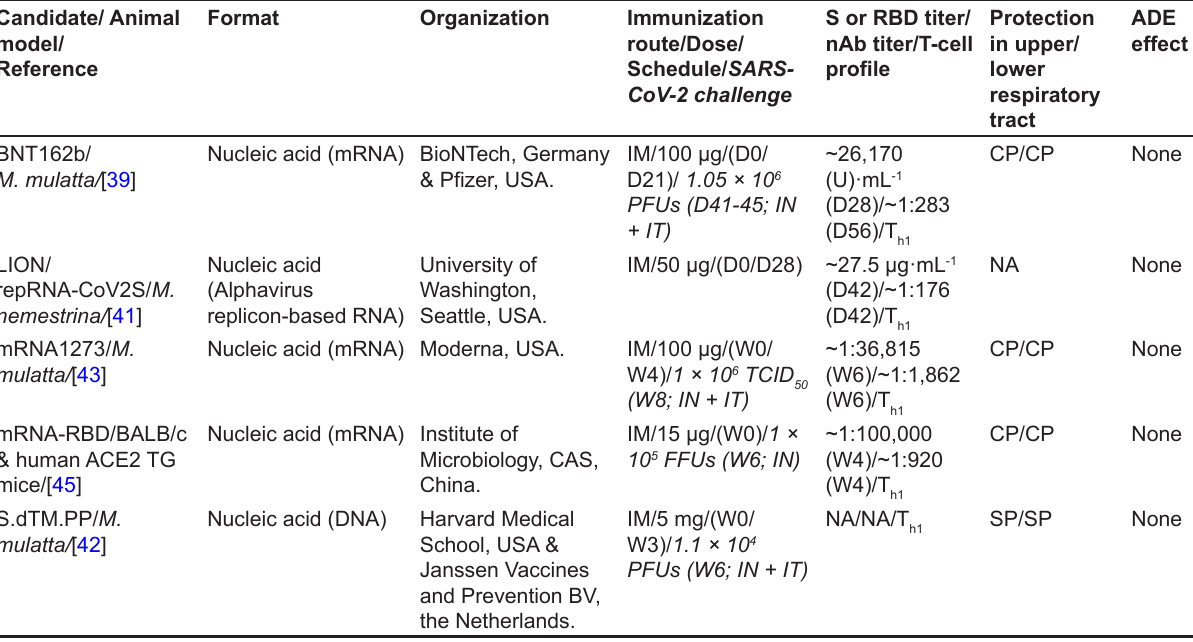
Table 1. Referred COVID-19 vaccine candidates ( continued )